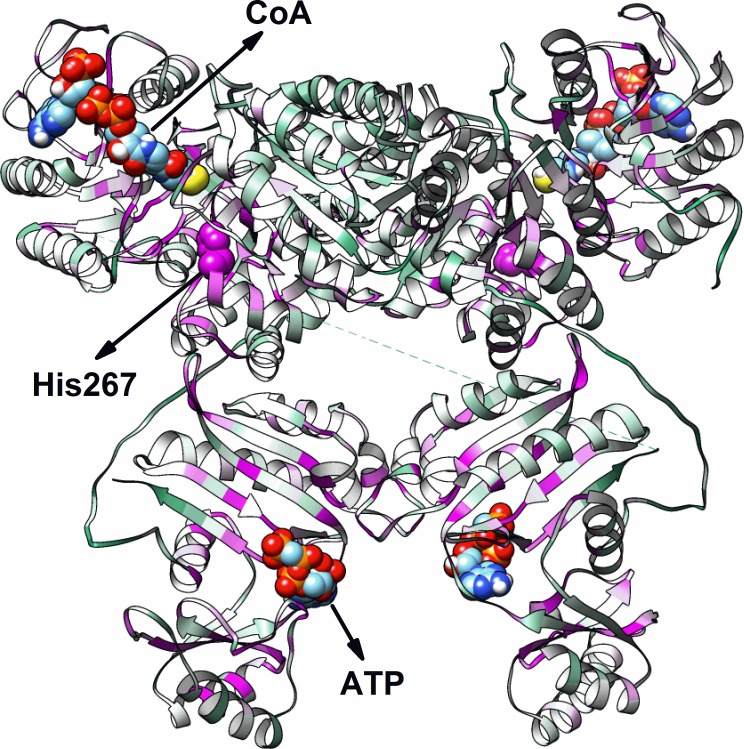
FCS1 homology model.N-terminal is composed by a Rossmann-like fold domain (CoA binding domain) followed by two domains with a flavodoxin-like fold, while the C-terminal corresponding to an ATP-grasp fold where is localized the ATP-binding site. CoA and ATP molecules are indicated in the figure and represented by colored spheres. The conserved residue His267 is represented by pink spheres. Structural distribution of conservation. Conservation degrees were converted into color gradients: pink—highly conserved (> 90%); white—partially conserved; green—little conserved (< 10%). Highly conserved residues (pink) are concentrated around the CoA and ATP molecules as well as around the conserved residue His267.